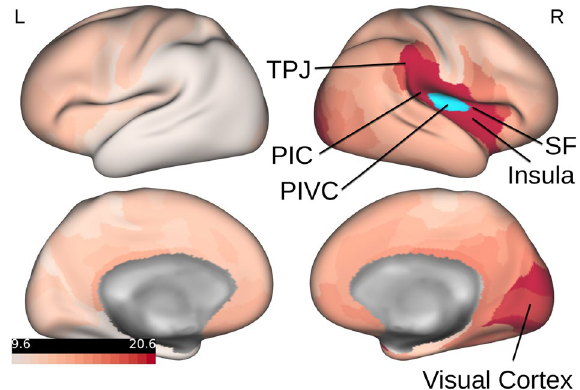
Figure 4. The figure illustrates the influence of activity in PIVC on all other brain regions. The left side depicts the left hemisphere, while on the right side the right hemisphere is shown. The target region PIVC in the right hemisphere is marked in blue. The values of the influence measure I ( n ′ ) were normalized between 0 and 100 and are encoded in red in this illustration. PIC posterior insular cortex, PIVC parieto-insular vestibular cortex, SF Sylvian fissure and surrounding perisylvian cortex, TPJ temporo-parietal junction. Note that causal relationships from right PIVC were primarily found in the ipsilateral hemisphere. The figure was created with the Connectome Workbench software (version 1.4.2): https:// www. human conne ctome. org/ softw are/ conne ctome- workb